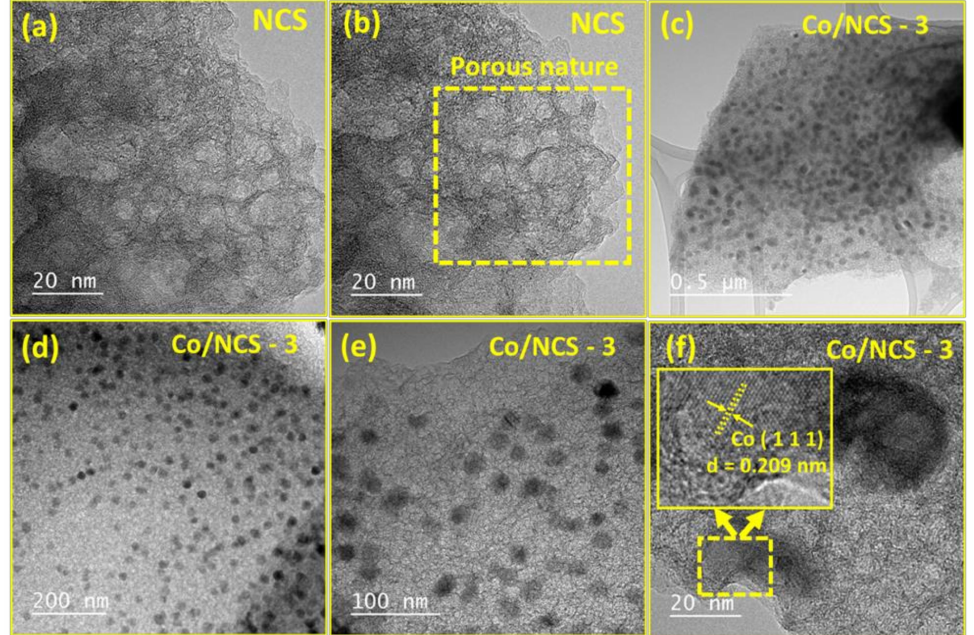
Figure 3. TEM images of NCS ( a , b ), Co/NSC-3 ( c – f ). The yellow box in figure ( b ) indicates the porous nature of NCS carbon. Inset of ( f ) shows the lattice fringes with the d = 0.209 nm corresponds to Co (1 1